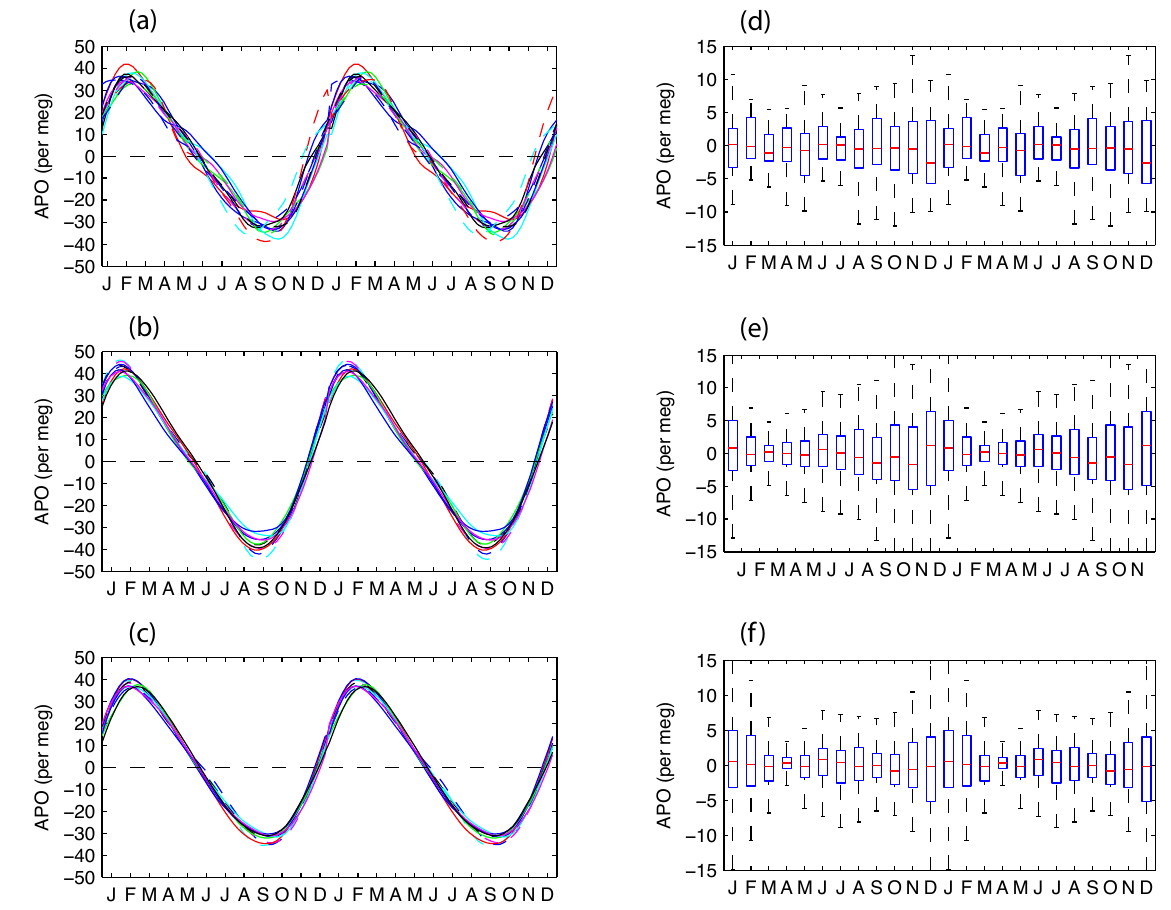
Figure 10. Atmospheric potential oxygen (APO), with each year shown separately over 1 July–30 June. (a) Observations from Scripps network, with each line corresponding to a separate year but repeated twice to facilitate interpretation. Each line represents a different year between 1998 and 2011. Solid lines are used for years that overlap with the model runs (1998–2005), while dashed lines are used for the more recent observations. (b) Model output from the CNTRL case over the period 1994–2005, with each line corresponding to a separate year but repeated twice. Solid lines are used for years that overlap with the observations (1998–2005), while dashed lines are used for the earlier period. (c) Model output from the WSTIR case, with each line corresponding to a separate year but repeated twice. Time period follows (b) . (d) Observations, bar and whiskers plot of intraseasonal variability inferred from STL analysis, with red lines showing mean (per meg) deviations, and blue boxes marking 25th and 75th percentile values of intraseasonal variations. Bars represent the full range of values, but outliers defined as values larger than 1.5 times the interquartile range, have been excluded. Time period follows (a) . (e) Same as (d) , but for CNTRL. Time period follows (b) . (f) Same as (e) , but for WSTIR. Time period follows (b)